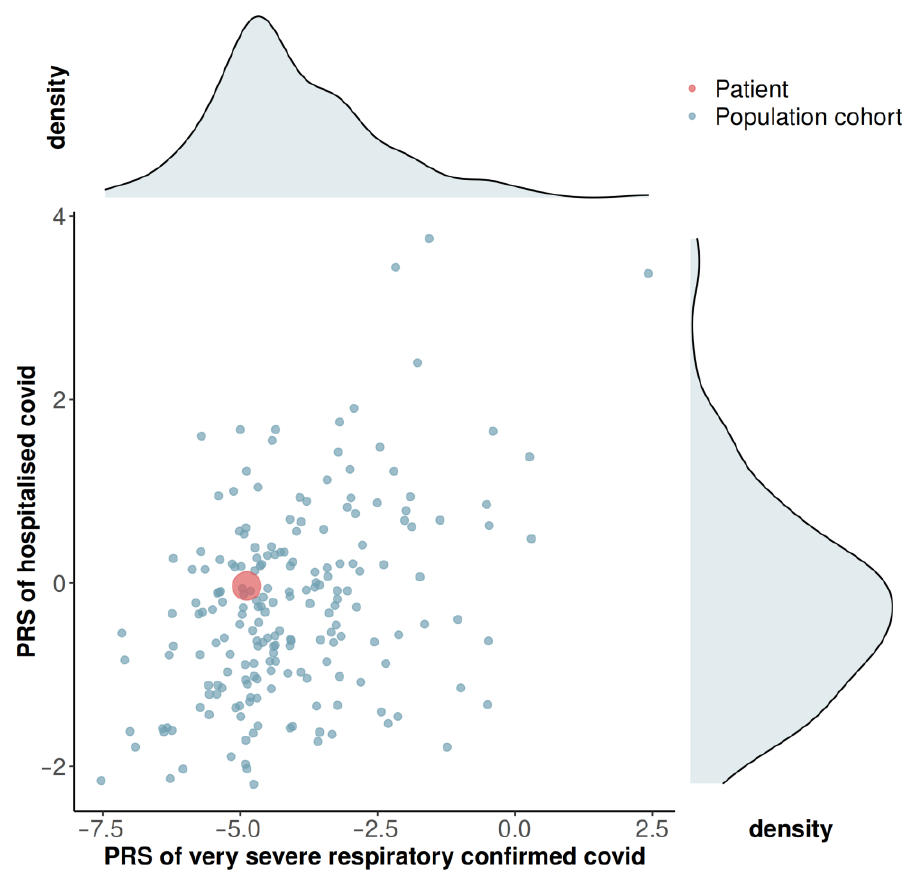
Figure 3. Scatter plot of the polygenic risk score (PRS) values and respective density plots for “very severe respiratory confirmed covid” and “hospitalized covid” phenotypes for the Portuguese population cohort ( n = 198), and the scatter point value for the patient (in red). The PRS values were calculated based on odd ratios reported online by the COVID-19 host genetics initiative (https://www.covid19hg.org/) [21].